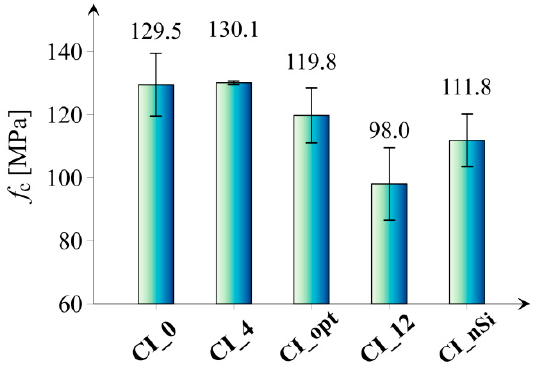
Figure 8. Results of compressive strength (f c ) of all tested series. Vertical bars indicate one standard deviation.